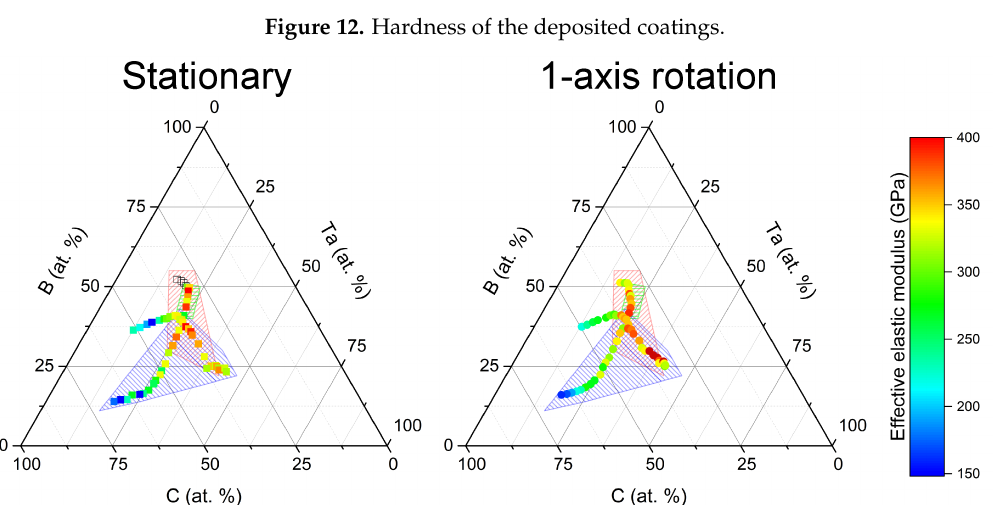
Figure 13. Effective elastic modulus of the deposited coatings.